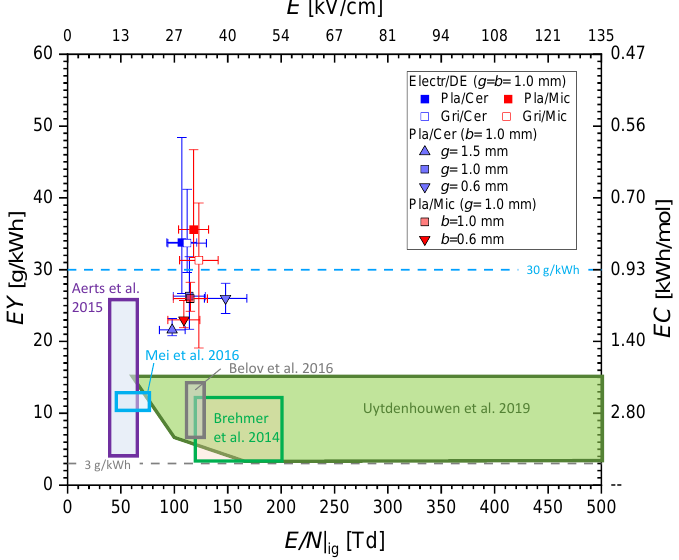
Figure 13. Energy yield EY or energy cost EC of CO formation as a function of the reduced electric field strength or electric field strength (at ignition) in comparison with results from literature, namely, Brehmer et al. [29], Aerts et al. [14], Mei et al. [16], Belov et al. [21], and Uytdenhouwen et al.